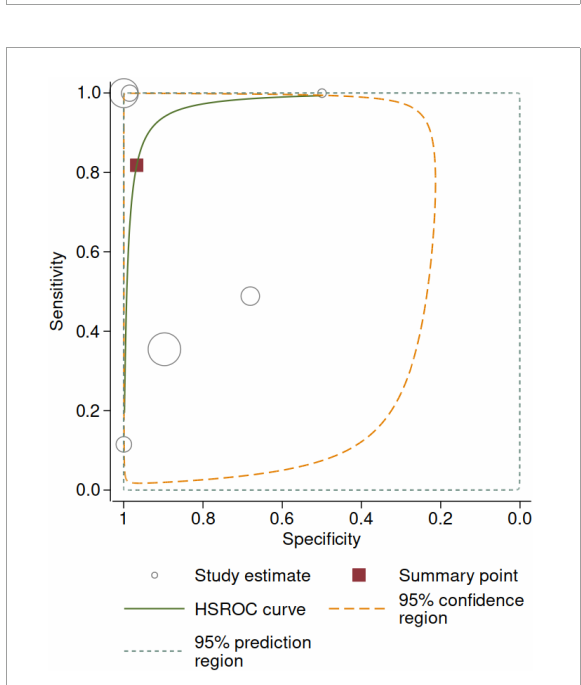
FIGURE5 Hierarchical summary receiver operating curve (HSROC). The size of the circles is proportional to the number of participants in each study. The 95% confidence region represents the uncertainty around the summary point. The 95% prediction region represents the uncertainty regarding the estimate to be obtained in a new, well-conducted study—given the observed data (i.e., current levels of statistical